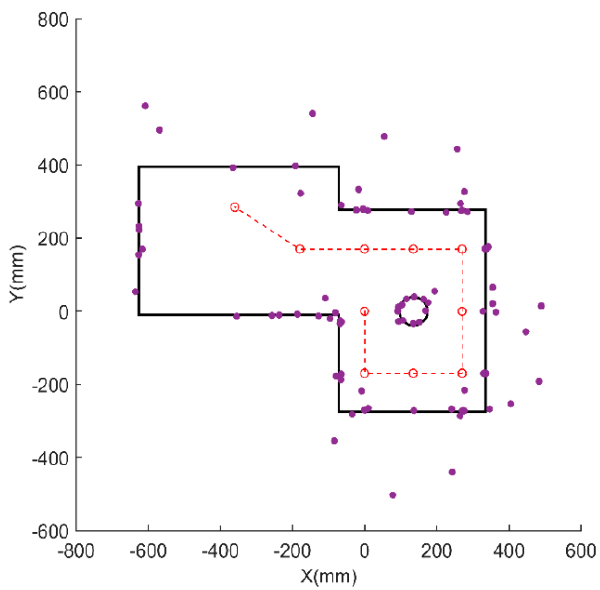
Figure 11. Object location extraction by MDP.